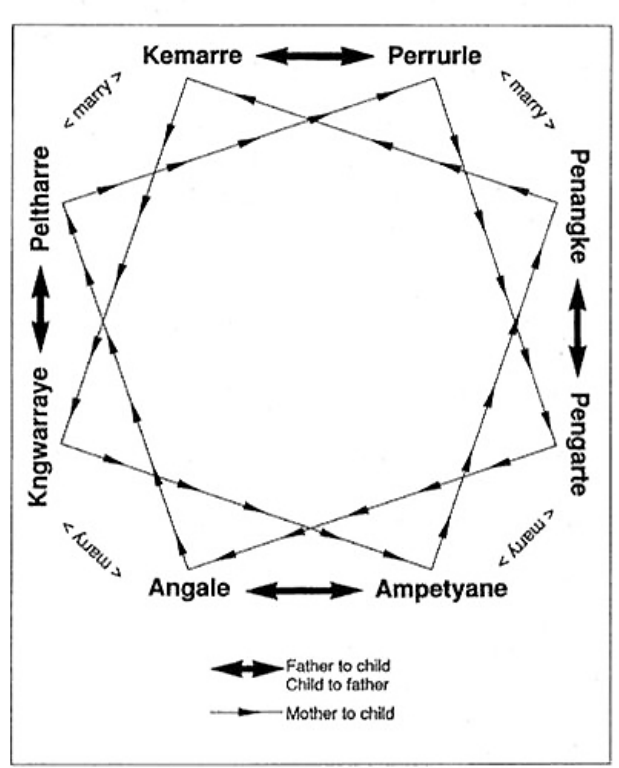
Fig. 6. Arrernte kinship group names and relationships (from Henderson and Dobson 1994). This shows how kinship groups are connected by marriage and inherited by children of that marriage. Every individual has a skin group. These relationships define people’s associations with particular land areas and certain